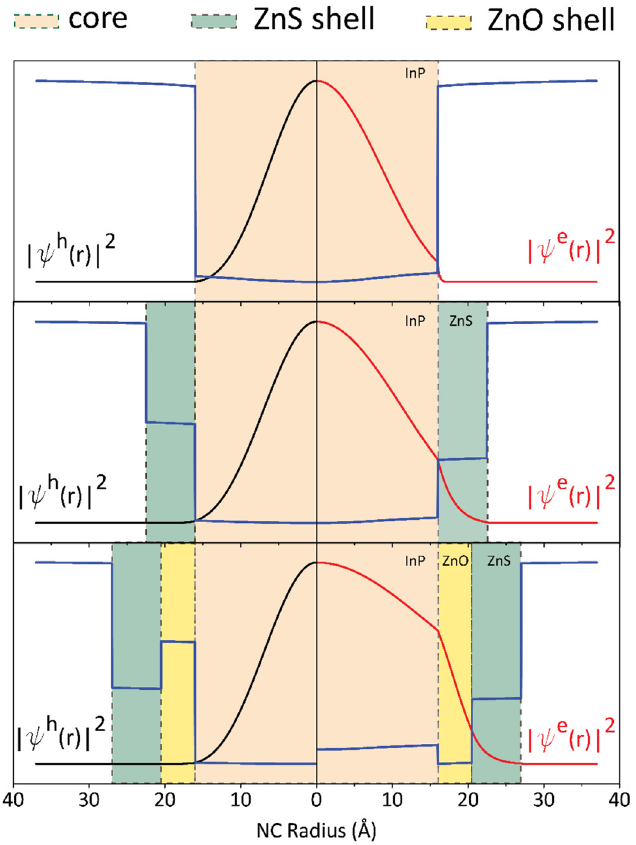
Figure 3. Radial distributions of electrons and holes throughout the InP core (top panel), InP/ZnS core/shell (middle panel) and InP/ZnO/ZnS core/shell/shell (bottom panel) quantum dots. The colored areas show the core region, ZnS shell region, and ZnO shell region. Blue lines show the respective conduction and valence band potential profile of each QD. The bending of the potential profiles is due to attractive Coulomb potential between the electron and